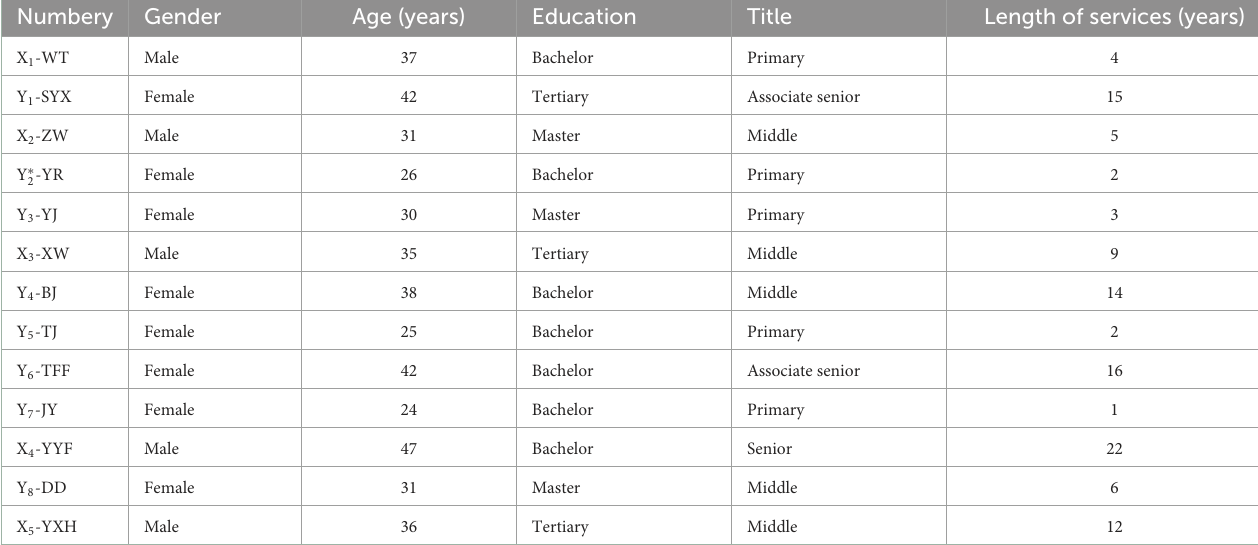
TABLE 1 Participants’ demographic information.